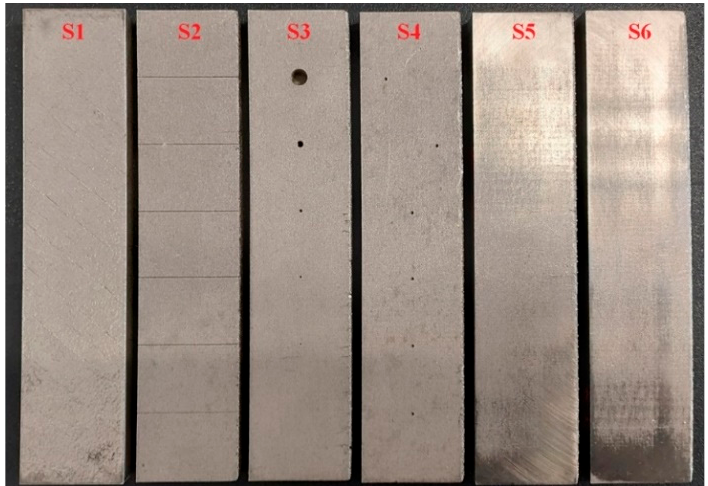
Figure 2. Stainless steel samples made by SLM technology.